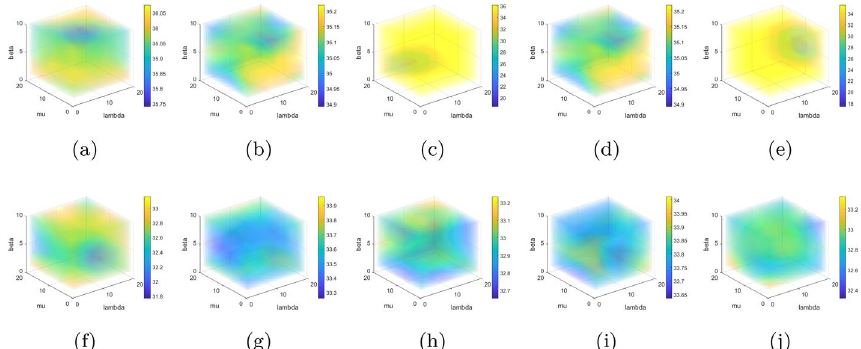
Fig. 9 Change in the MPSNR values of Proposed method for the Pavia City Center image (top) and the Washington DC Mall image (bottom) by varying parameters (cid:31) , µ and β . The data were corrupted by the noise simulated in Case 1 and Case 2 with σ 0.05 and o 0.01: a , f r 0.3, v 0.075; b , g r 0.5, v 0.075; c , h r = = = = = = 0.7, v 0.075; d , i r 0.3, v 0.05; e , j r 0.3, v = = = = = =